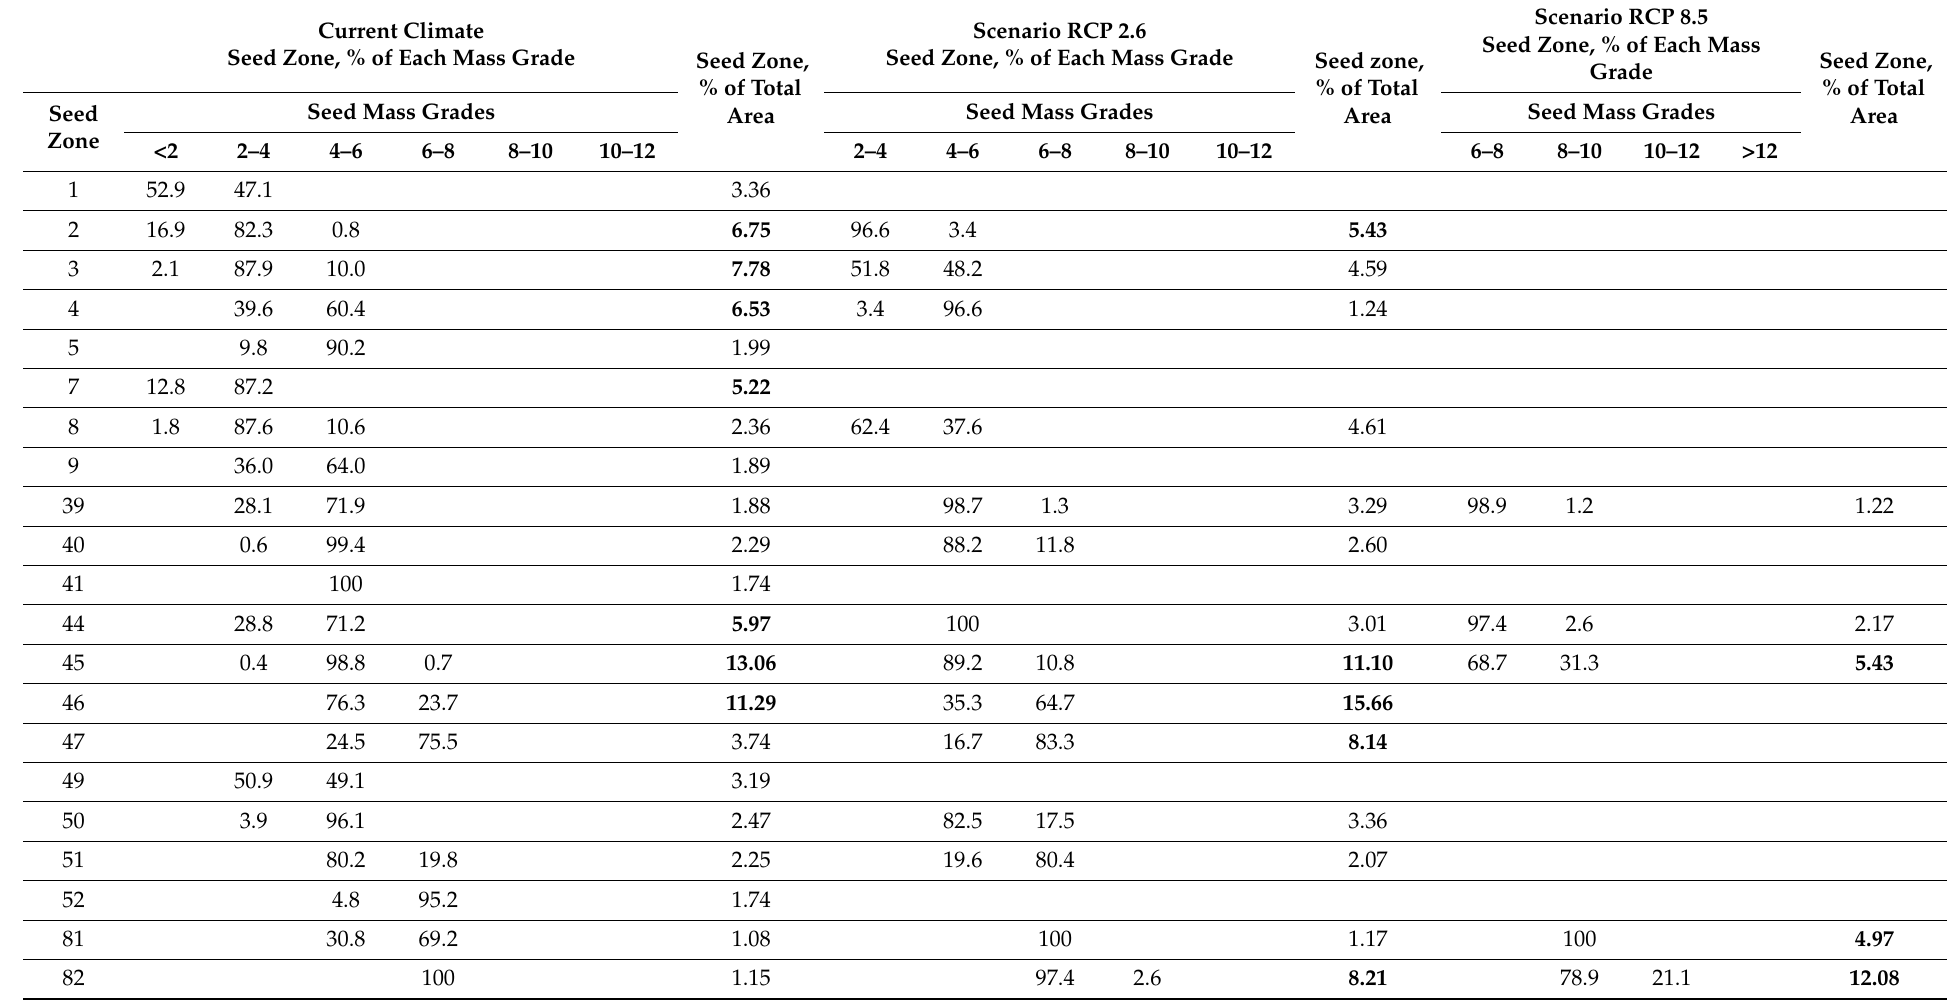
Table 2. Scots pine seed zone coverage (%, >5% of the total range in bold) of various seed mass grades (the prevailing grade, % of a seed zone, is in bold) in contemporary and future climates in